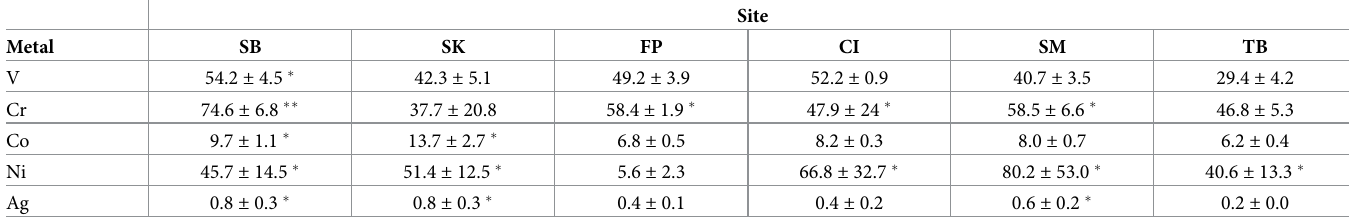
Table 3. Mean metal concentration (mg/kg) in sediment of salt marsh sites.